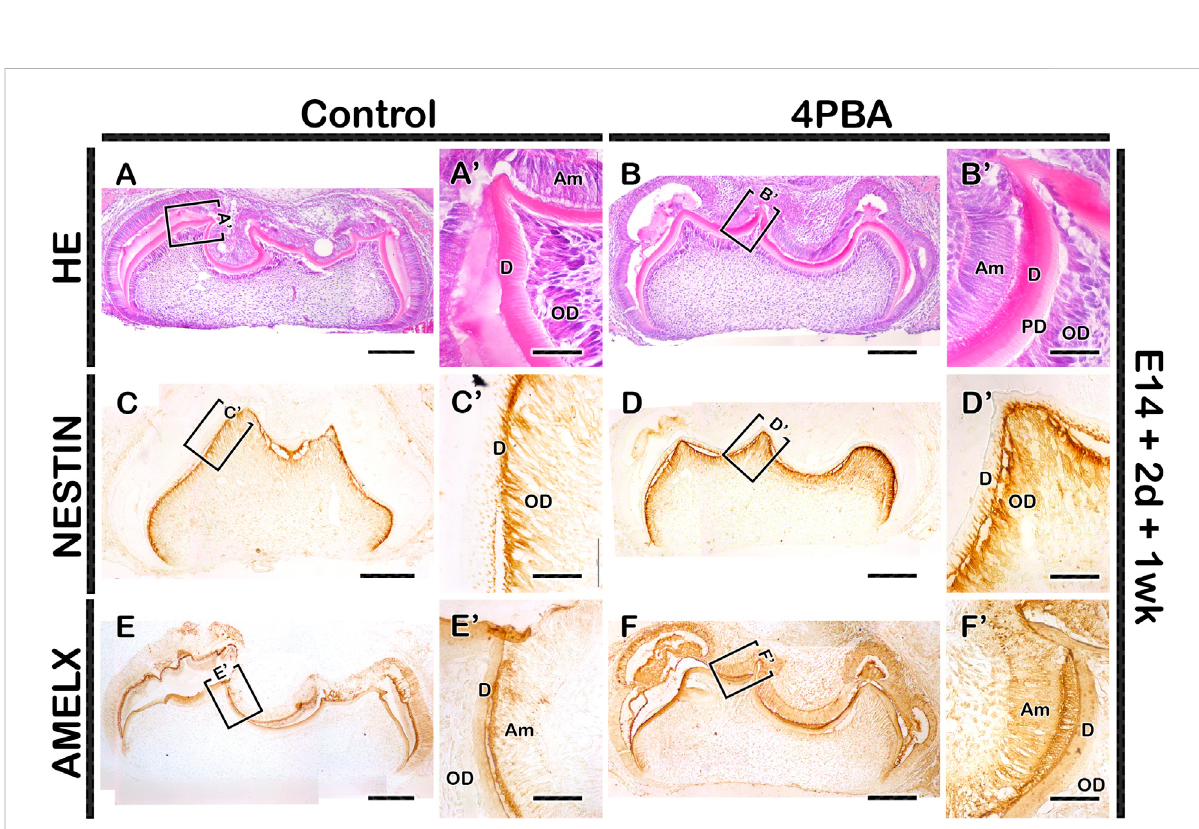
FIGURE 4 Histology and localization patterns of NESTIN and AMELX in renal calci fi ed teeth. HE staining showing comparably thicker enamel and dentin layers in the 4PBA treated teeth compared to controls (AA 9 ,BB 9 ) . Similarly, the localization patterns of NESTIN and AMELX are stronger in the 4PBA treated teeth when comparedto control group (CC 9 – FF 9 ) . Boxes indicate enlarged views (A – F) . Am, ameloblast; OD, odontoblast; PD, predentin; D, dentin. Scale bars: 200 μ m (A – F) , 50 μ m (A 9 – F 9 )